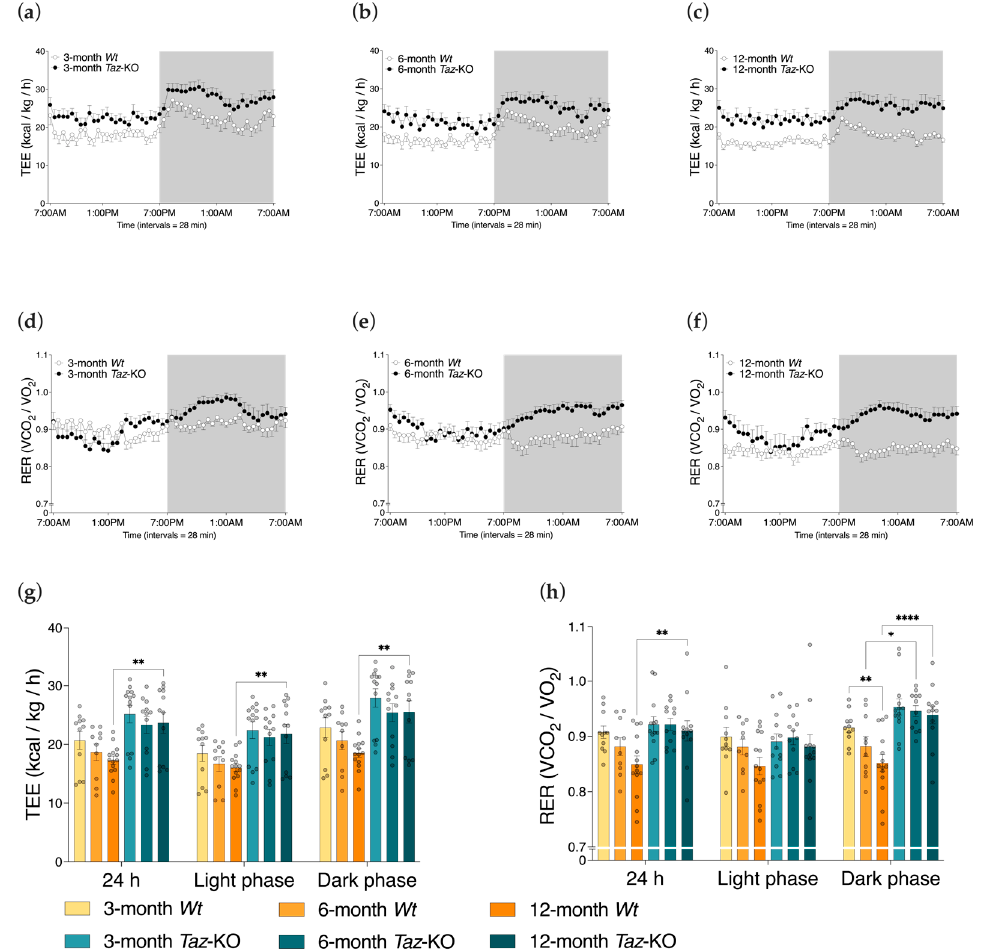
Figure 6. Higher energy expenditure and respiratory exchange ratios in Taz -KO mice. Three sepa- rate mouse cohorts, aged 3, 6, and 12 months, were housed in metabolic chambers for 24 h. Plots of mean total energy expenditure (TEE) normalized to total body weight ( a – c ) and respiratory exchange ratios (RER) ( d – f ) are shown. Dark phase (denoted by shaded background) and light phase (denoted by unshaded background) cycles are shown. Bar graphs of daily averages, in addition to averages by photoperiod, of TEE ( g ) and RER ( h ) are shown. Statistical analysis was performed using two-way ANOVA followed by Bonferroni’s multiple comparisons tests. Data are means ± SEM ( n = 10–14). * p < 0.05, ** p < 0.01, **** p < 0.0001.